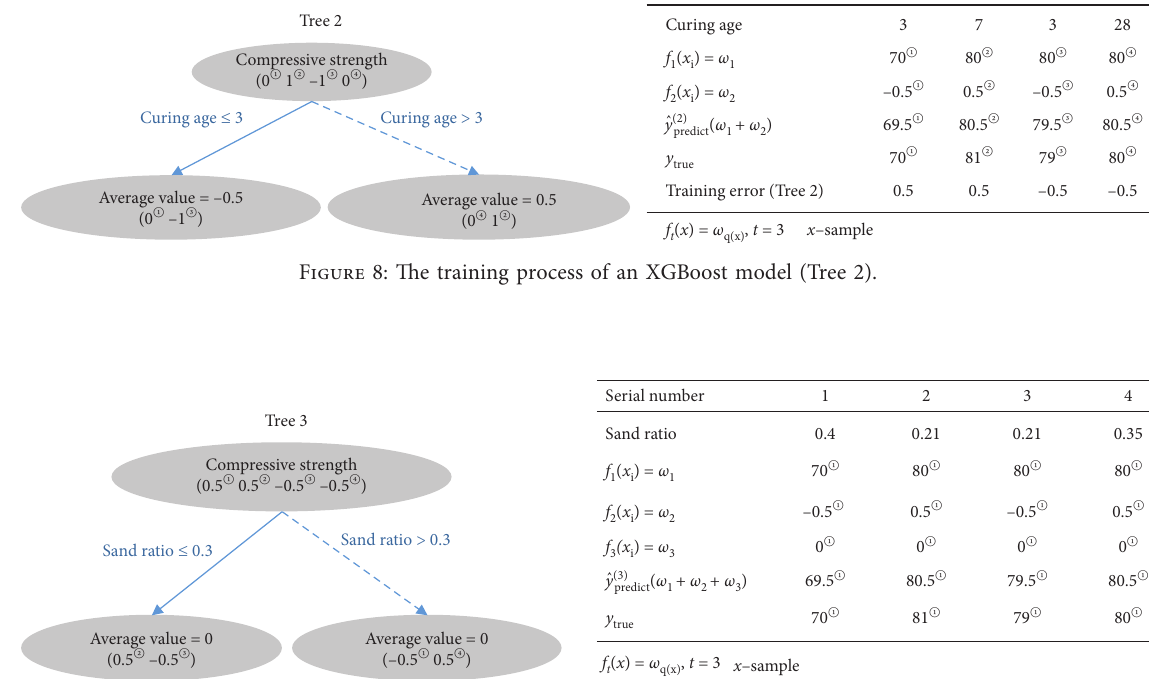
Figure 9: The training process of an XGBoost model (Tree